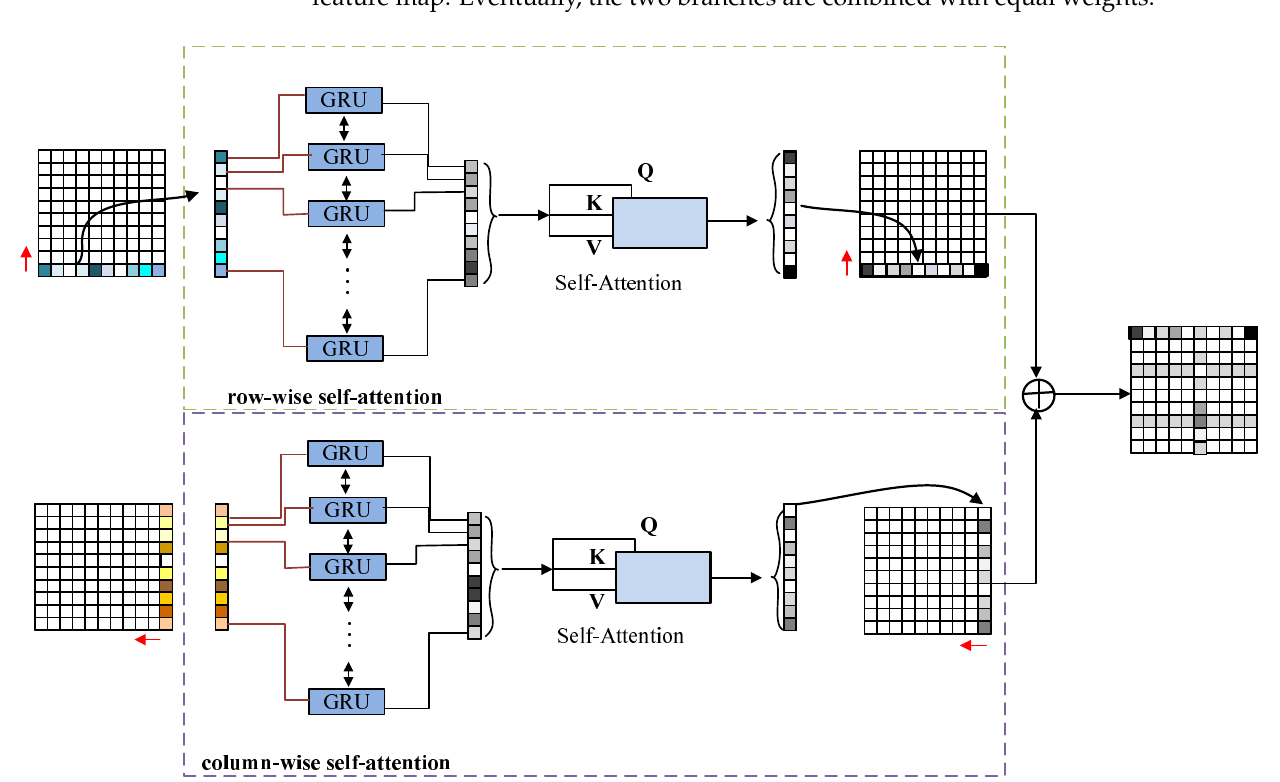
Figure 5. Attention layer consisting of column-wise and row-wise self-attention